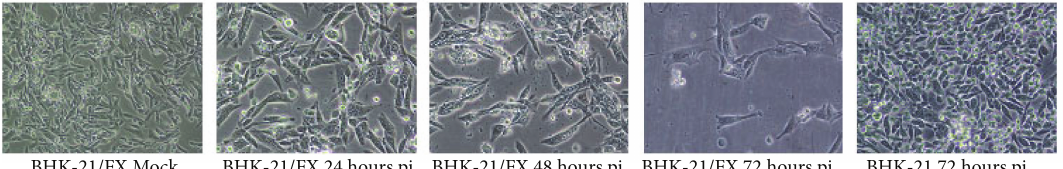
Figure1:CytopathogenicityofBHK-21/FXcellstoinfluenzavirusinfections(MOI0.01)atintervalhourspostinfection(200xmagnification). The BHK-21 cells infected with influenza virus did not manifest cytopathic effects.